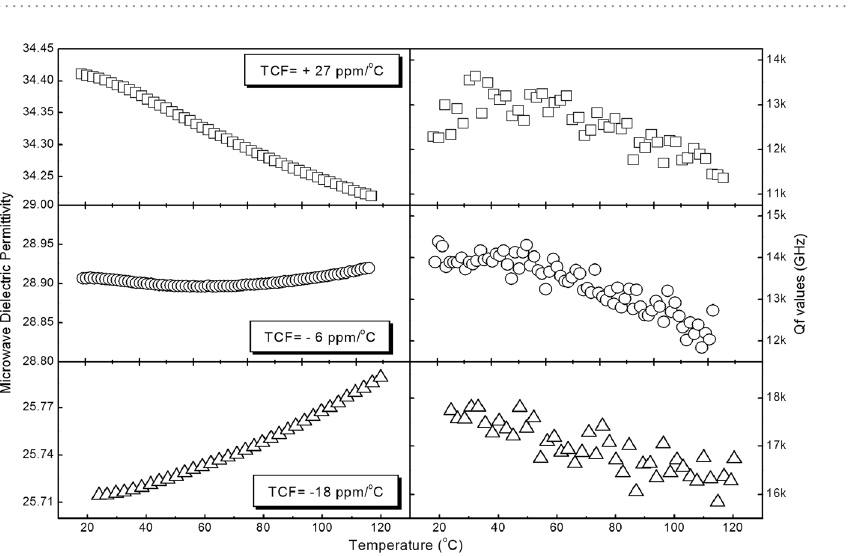
Figure 3. Microwave dielectric permittivities and Qf values of the (Na 0.5 Bi 0.5 )(Mo 1 − x W x )O 4 (x = 0, 0.5, 1.0) ceramics as a function of